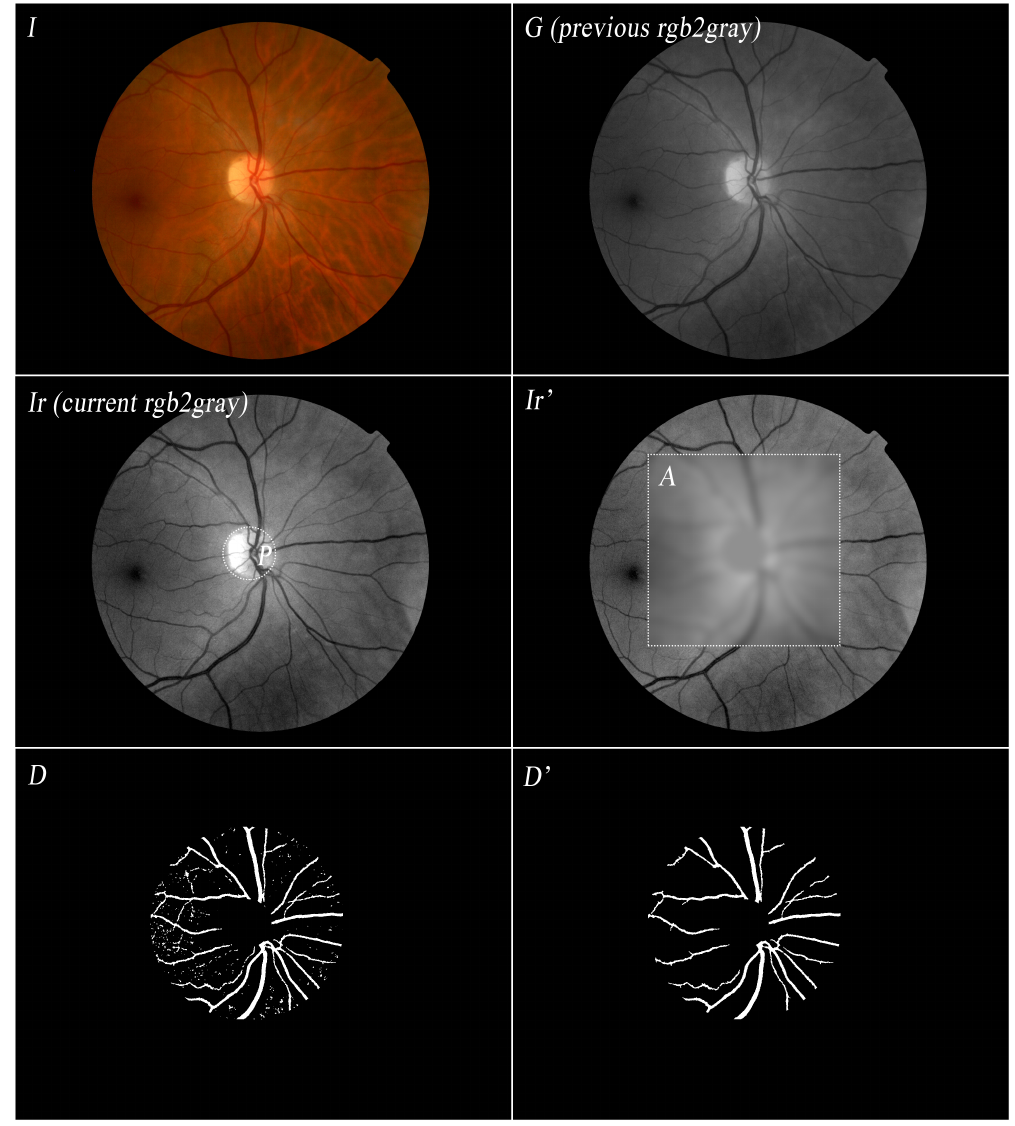
Figure 5. Vessel detection filters